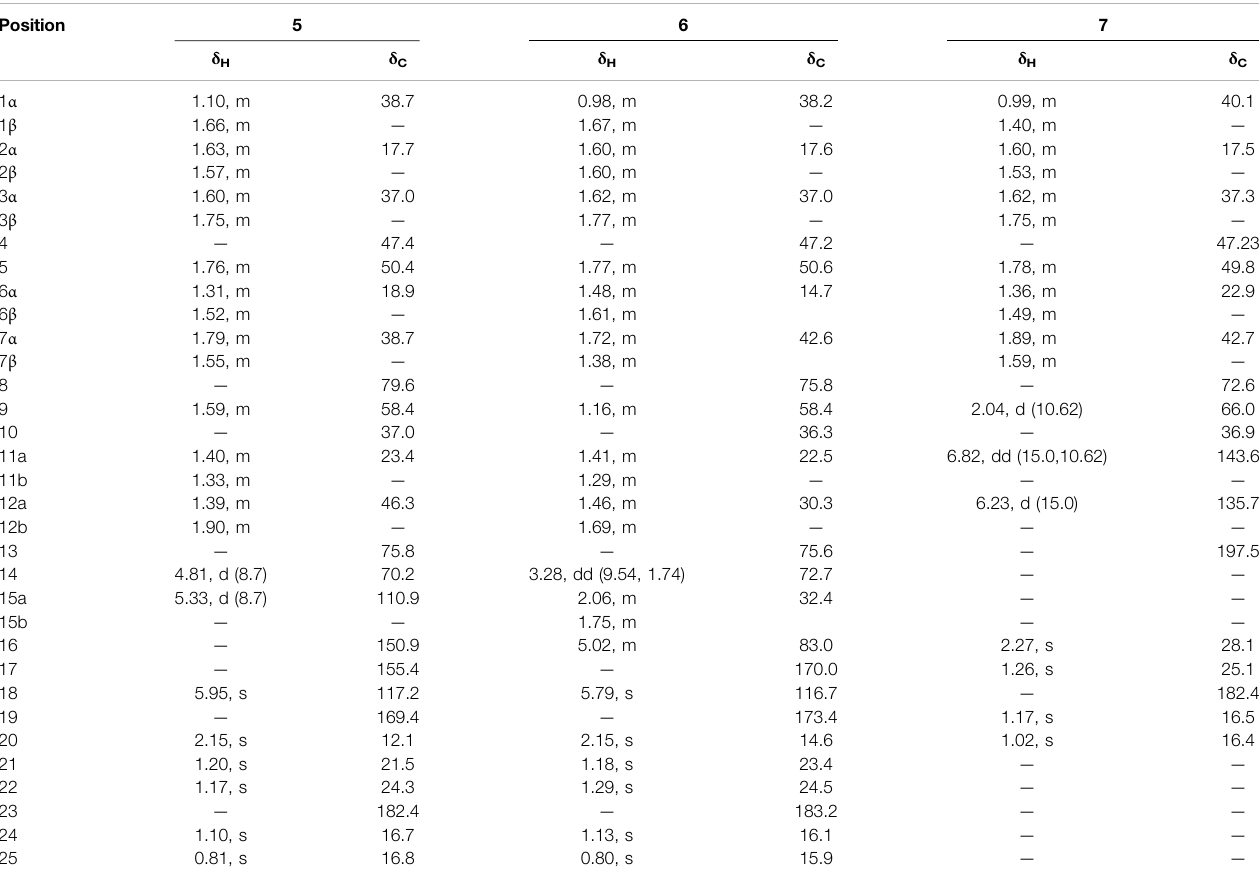
TABLE 2 | 1 H and 13 C NMR spectroscopic data of compounds 5 – 7 (600 MHz, δ in ppm, J in Hz)